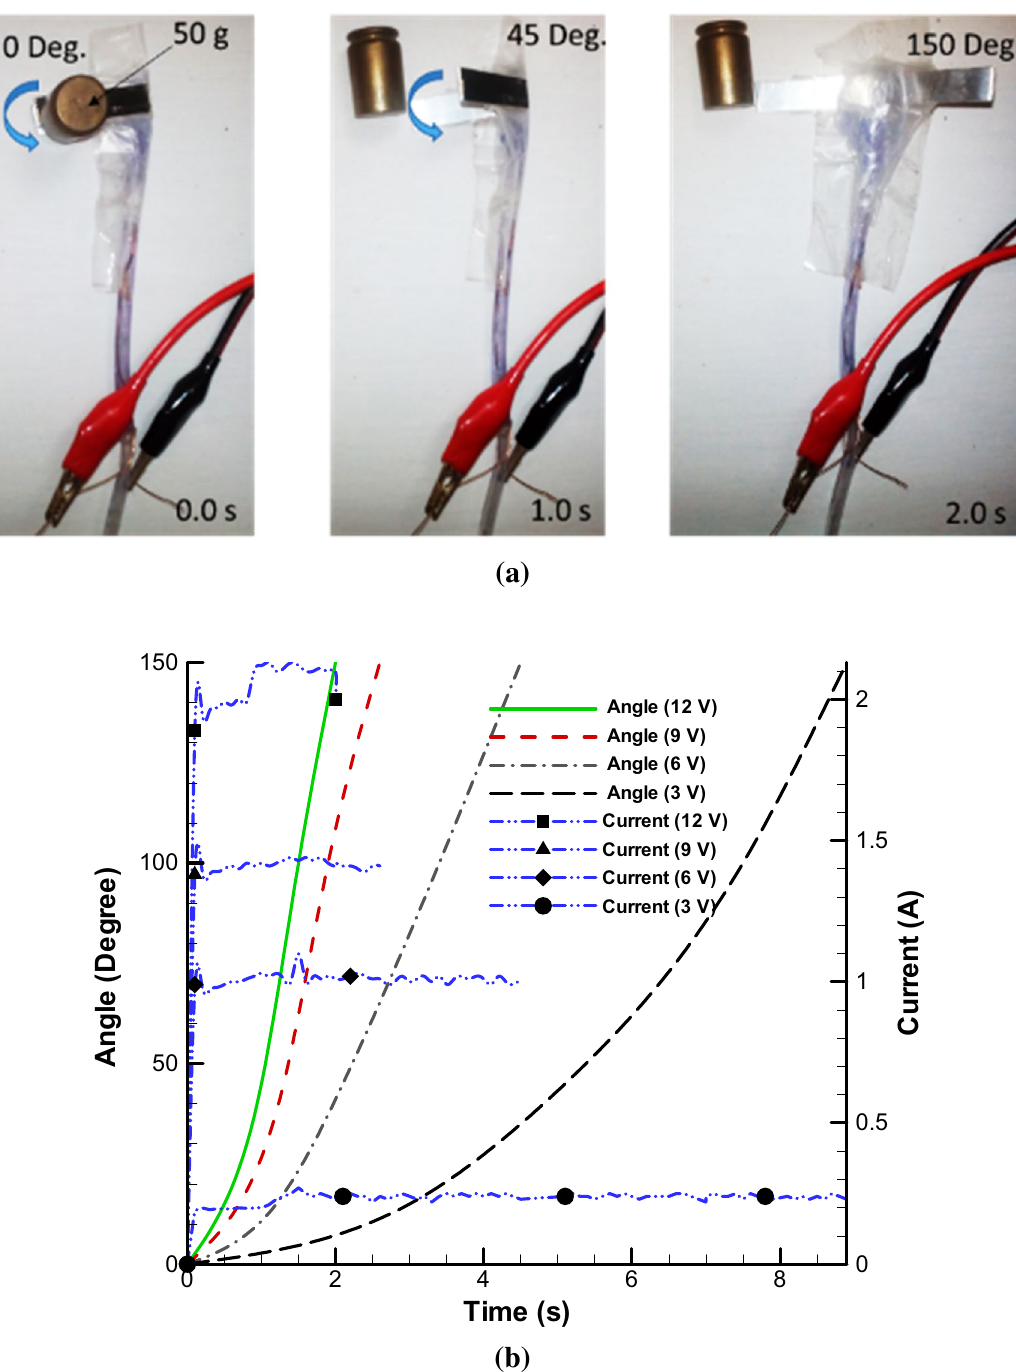
Figure 4. Angular rotation of single soft skin-solid structure without any loading condition. Angular rotation of pure electrolysis of single soft skin for 2 s (a) in 12 v. Plot of various angular rotation over time in different voltages (b)